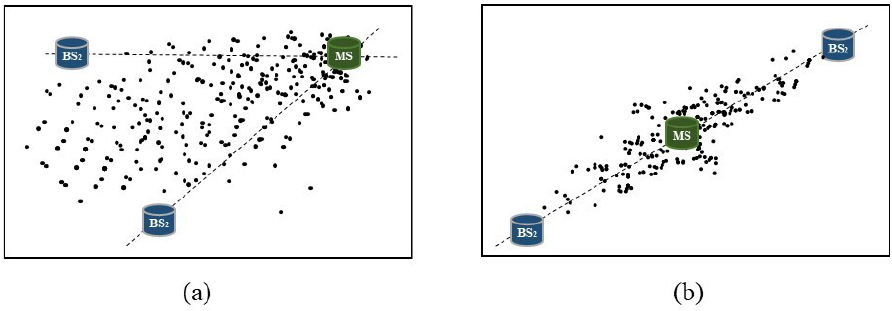
Figure 3. The influence of GDOP on location. ( a ) Two NLOS BSs in the same direction. ( b ) Two NLOS BSs in the opposite direction.